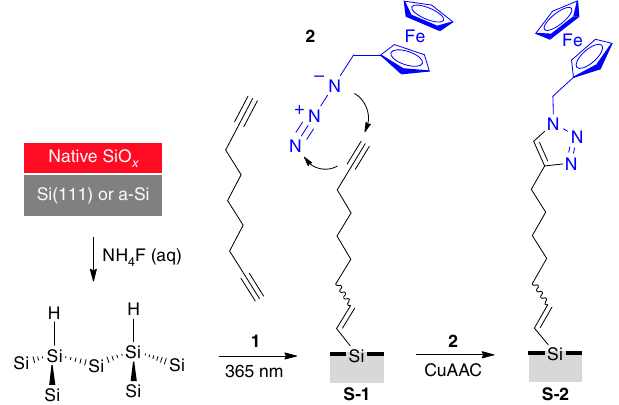
Fig. 1 The surface model system. Light-assisted hydrosilylation of 1,8- nonadiyne 1 is used to chemically passivate a Si – H electrode and generate an acetylene-terminated monolayer ( S-1 ). Azidomethylferrocene 2